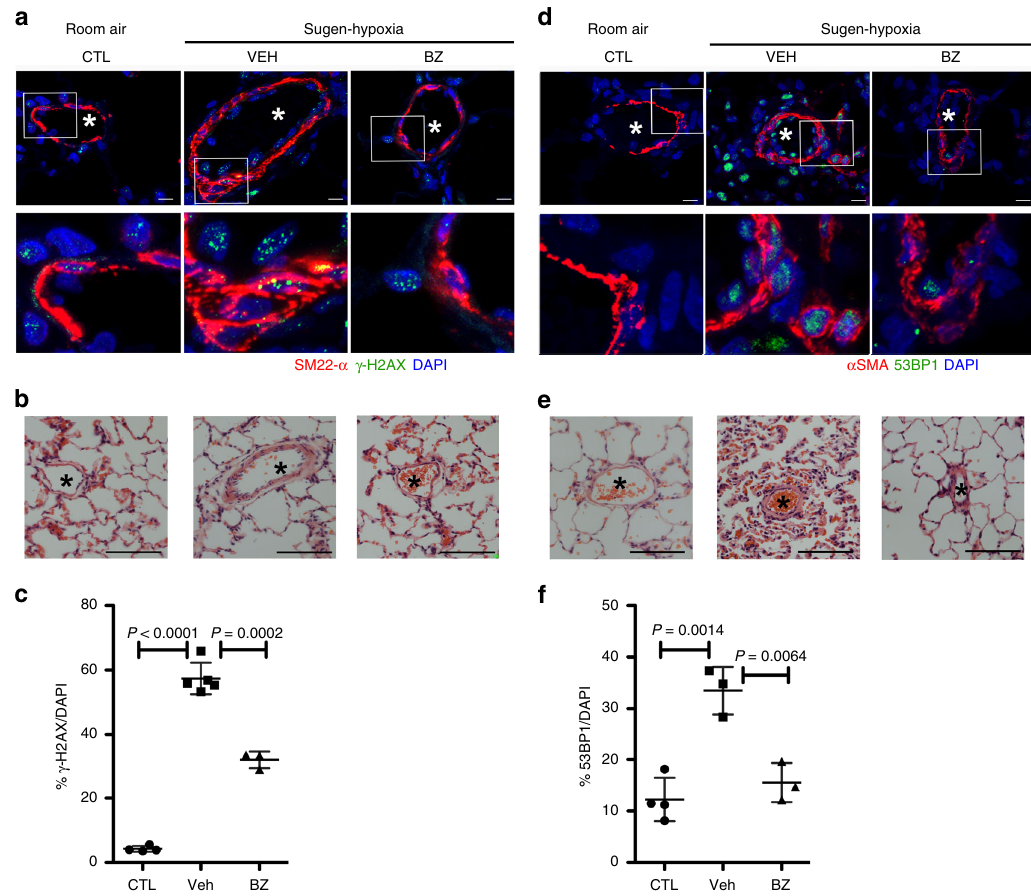
Fig. 7 EYA-PTP inhibition reduces markers of DNA damage and repair. a BZ treatment reduces the formation of DDR foci in rat lungs subject to the Su-Hx protocol. γ -H2AX (green) in rat lung tissue maintained in room air (CTL) and subject to the Su-Hx protocol. γ -H2AX is seen in both SMC (red; SM22- α positive) and non-SMC. DAPI (blue) staining indicates nuclei. Higher magni fi cation of the boxed areas shown in the lower panel. b H&E images of serial sections indicating the blood vessels imaged in ( a ). Scale bar = 100 μ m. c Quantitation of γ -H2AX-positive cells. Tissue sections were analyzed for DNA- damage repair as marked by the presence of γ -H2AX foci. At least four sections per animal were averaged for each data point. CTL rats maintained in room air n = 4, VEH vehicle-treated animals subject to the Su-Hx protocol n = 5, BZ treatment protocol n = 3. Data plotted as the mean ± SD, statistical signi fi cance derived from pairwise t -tests. d BZ treatment reduces the formation of 53BP1 foci in rat lungs subject to the Su-Hx protocol. 53BP1 (green) in rat lung tissue maintained in room air (CTL) and subject to the Su-Hx protocol. Sections were also stained with antibodies toward α -SMA (red) and DAPI (blue). Higher magni fi cation of the boxed areas shown in the lower panel. e H&E images of serial sections indicating the blood vessels imaged in ( d ). Scale bar = 100 μ m. f Quantitation of γ 53BP1-positive cells. Tissue sections were analyzed for the assembly of DNA-damage repair as marked by the presence of 53BP1 foci. At least four sections per animal were averaged for each data point. CTL rats maintained in room air n = 4, VEH vehicle-treated animals subject to the Su-Hx protocol n = 3, BZ treatment protocol n = 3. Data plotted as the mean ± SD, statistical signi fi cance derived from pairwise t -tests. Source Data are provided as a Source Data fi